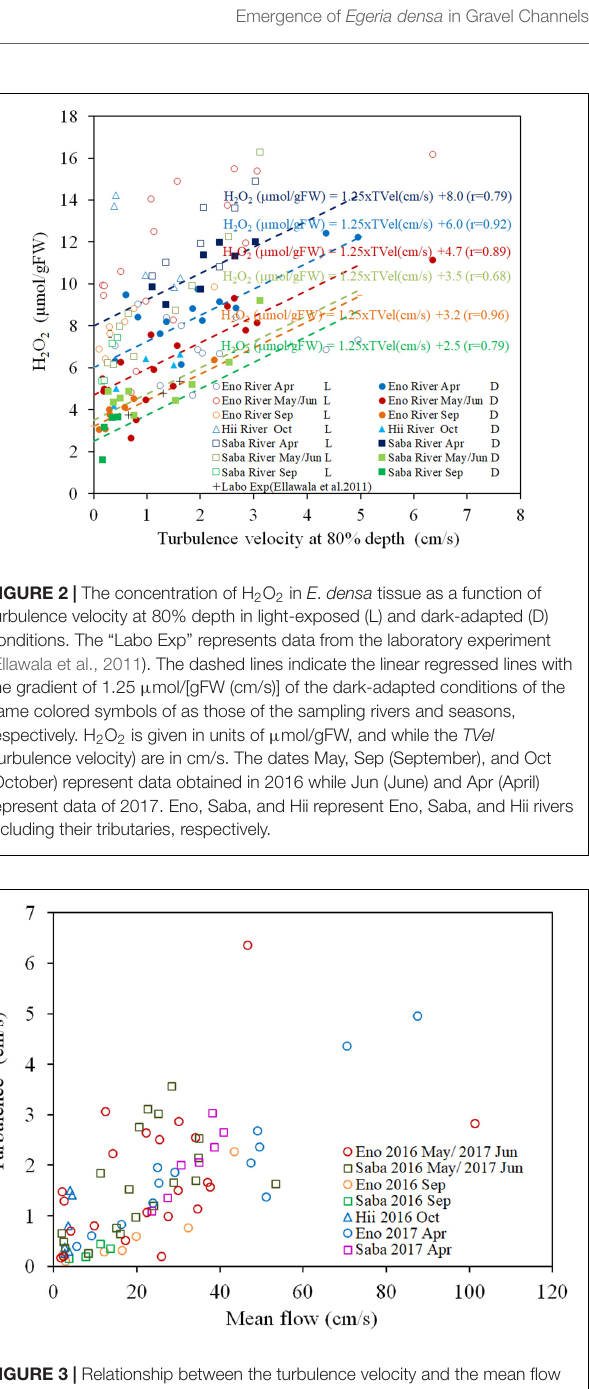
FIGURE 3 | Relationship between the turbulence velocity and the mean flow velocity of each sampling site of different rivers. The sample collected month is represented by the month indicated in the legend. Eno, Saba, and Hii represent Eno, Saba, and Hii rivers, including their tributaries,